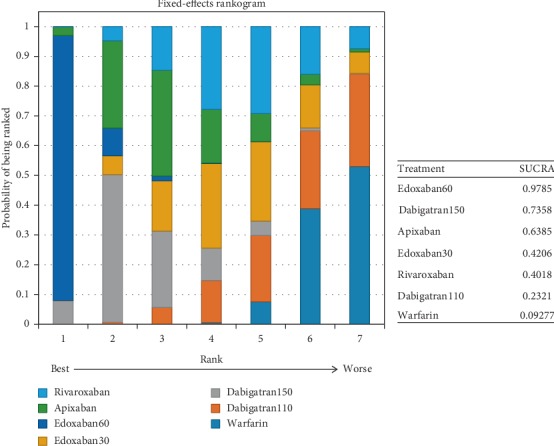
Ranking plots for the efficacy of the comparison among different treatments of patients with mild renal function.